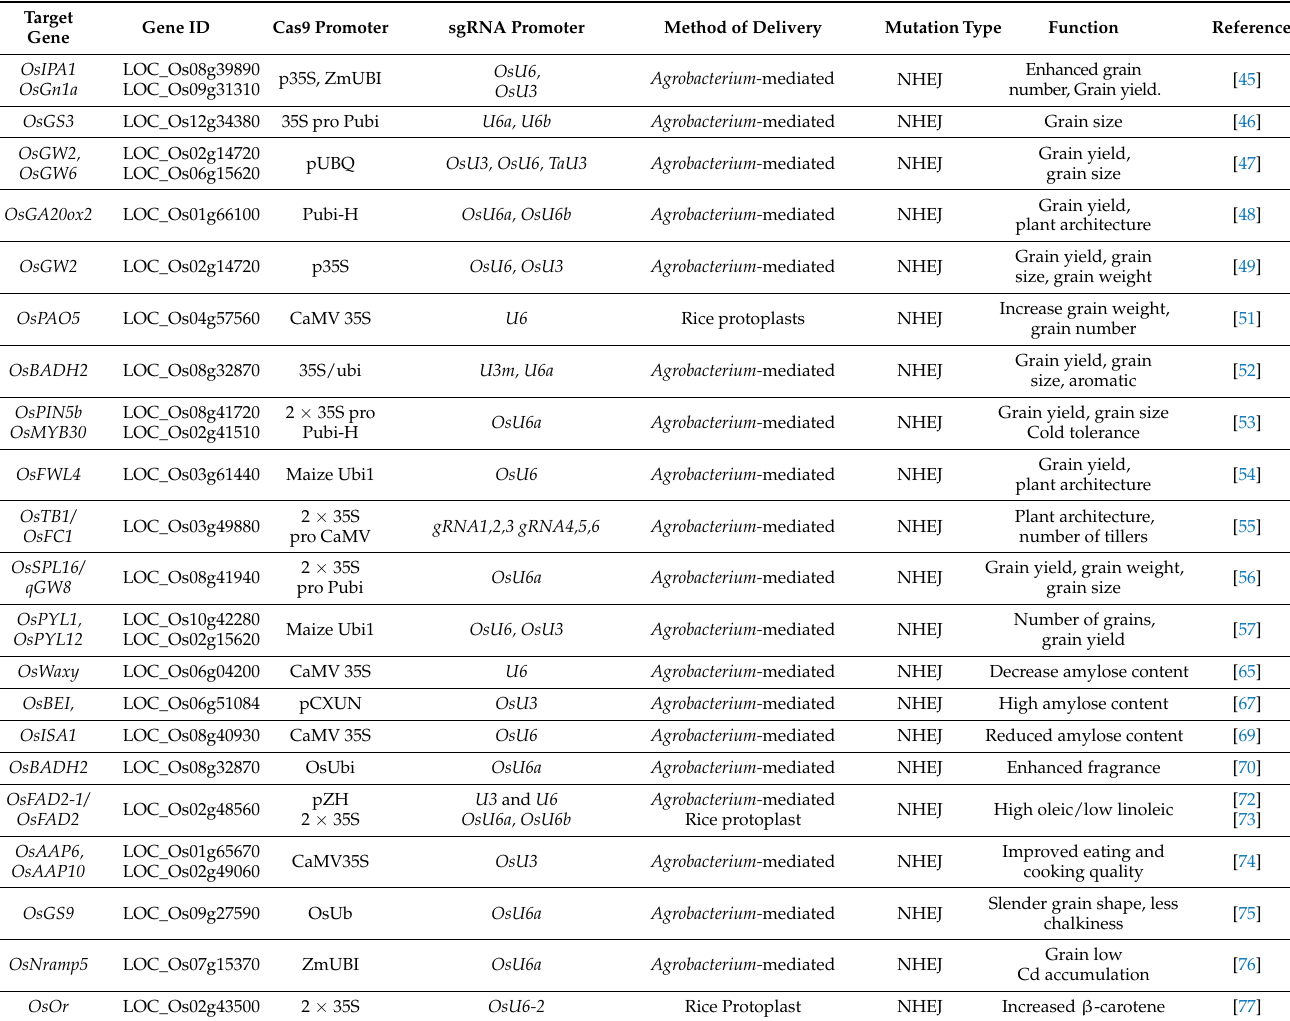
Table 1. Application of CRISPR/Cas9 system to increase yield, nutrition quality, and other agronomic traits in